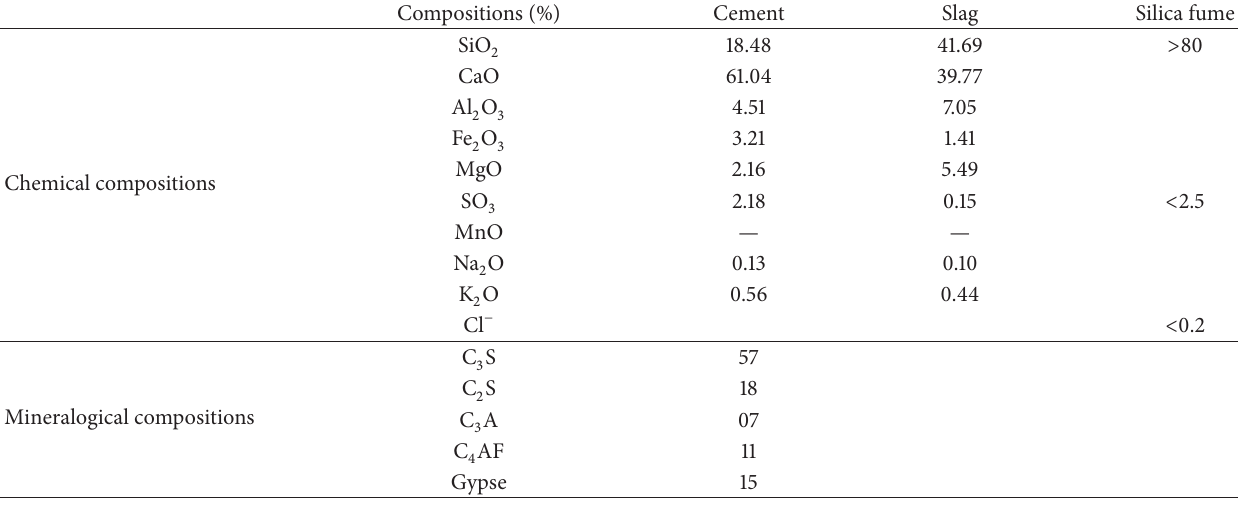
Table 1: Chemical and mineralogical composition of cement, granulated slag, and silica fume.